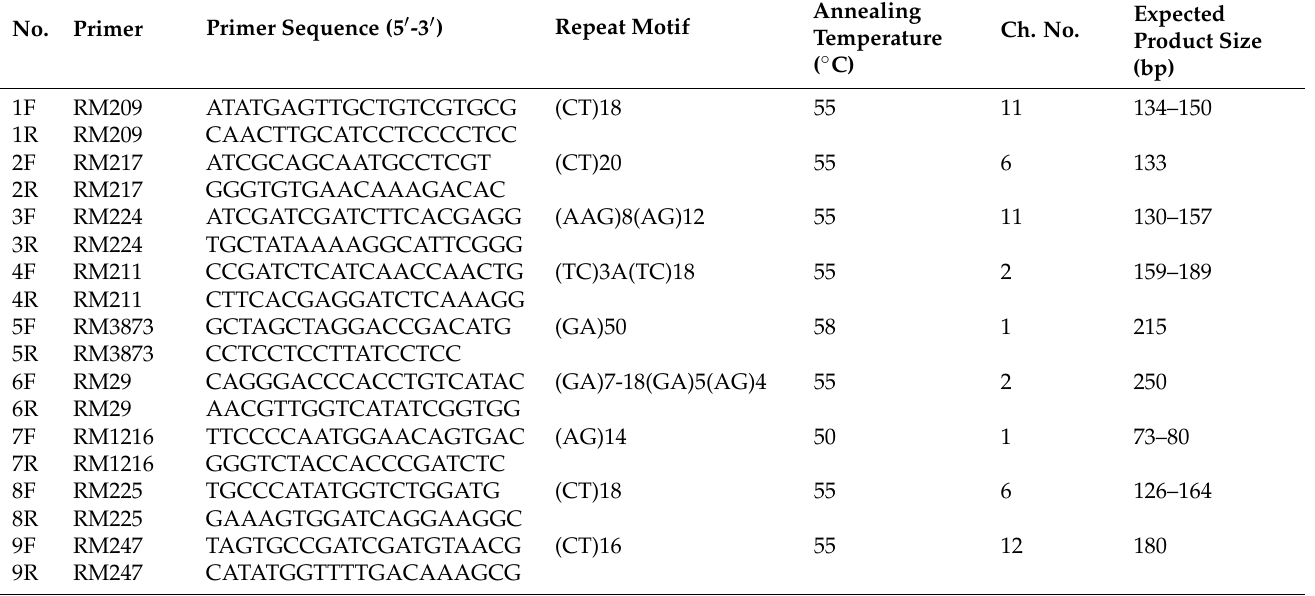
Table 3. List of SSR primers used in rice